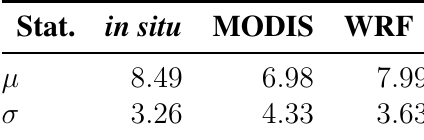
Table 3. Basic statistics from spatially averaged time-series of the three dataset. Stat. in